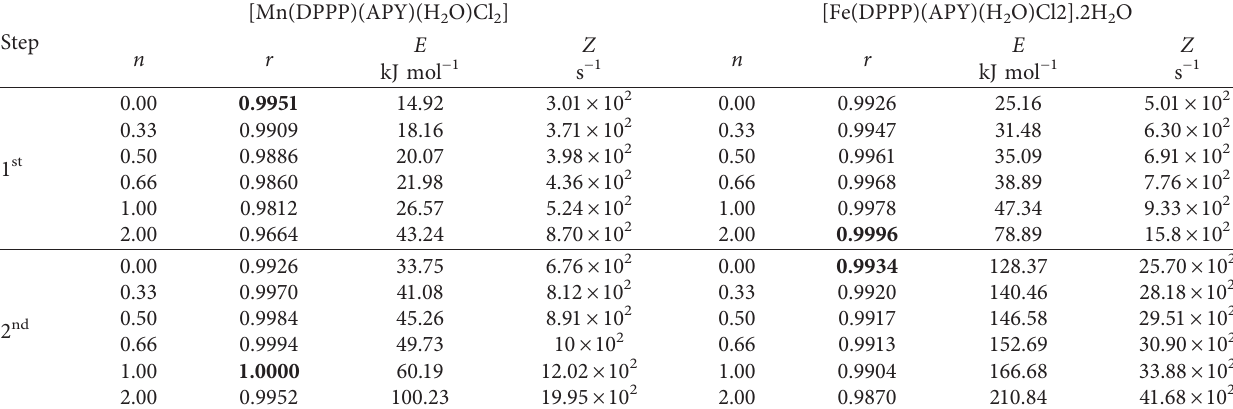
Table 5: Kinetic parameters for the thermal decomposition of Mn(II) and Fe(II) complexes using nonmechanistic equations in dynamic air by Coats–Redfern